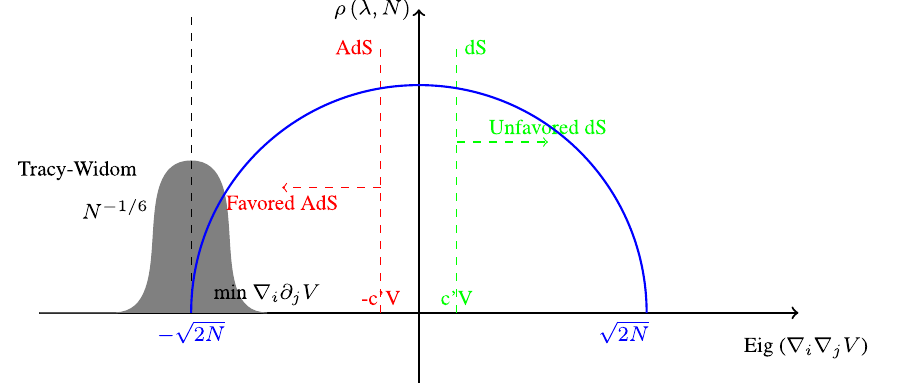
(cid:8) (cid:9) min ∇ i ∇ j V < c (cid:4) V which